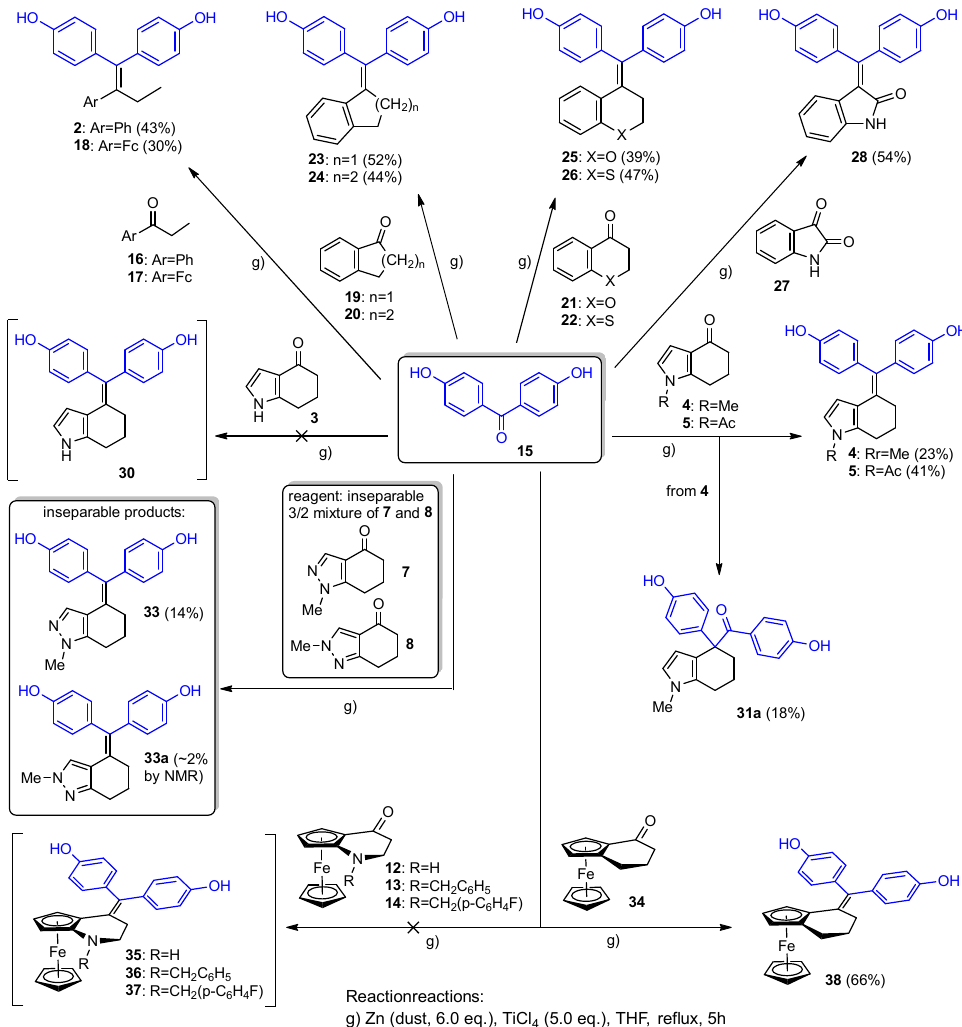
Scheme 4. McMurry reactions of 4,4′-dihydroxybenzophenone ( 15 ) leading Tamoxifen analogues.